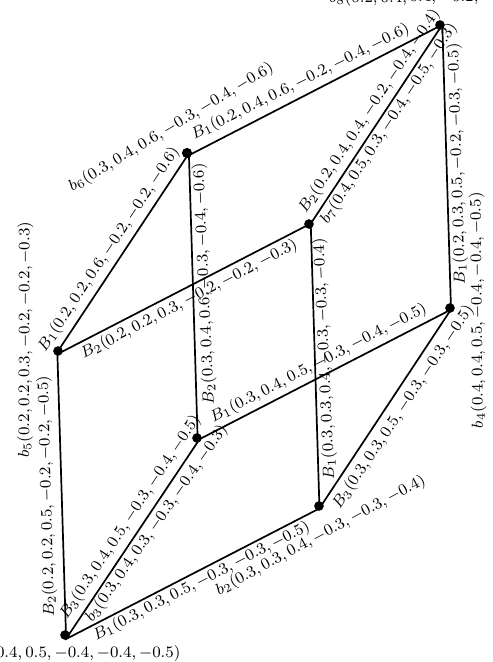
ˇ G ( B , B ) 1 , B 2 , B 3 bn =